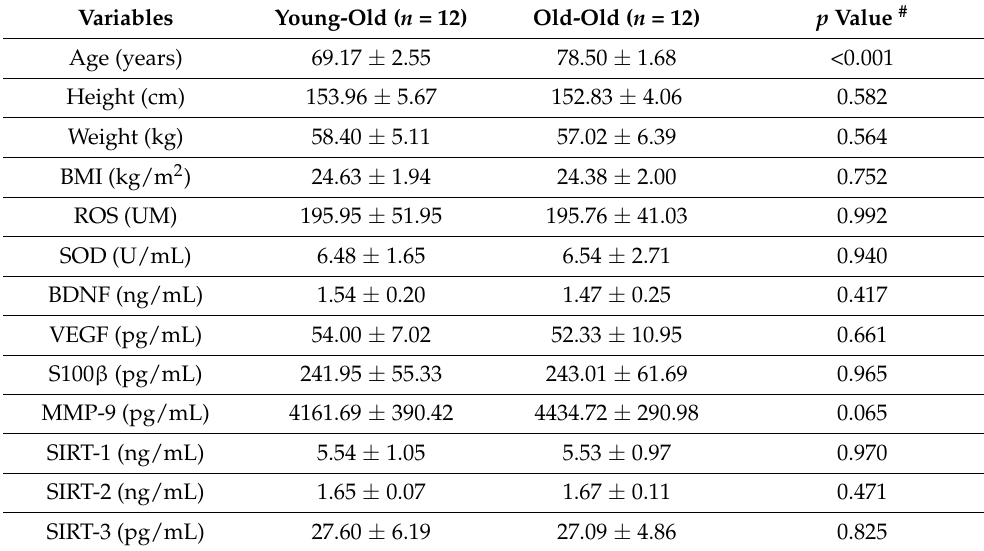
Table 1. Baseline biochemical and anthropometric characteristics of